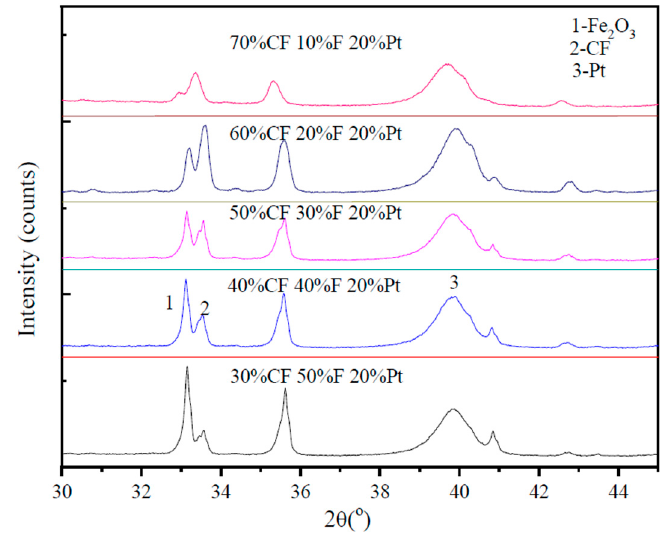
Figure 6. The X-ray diffraction patterns of standard samples.